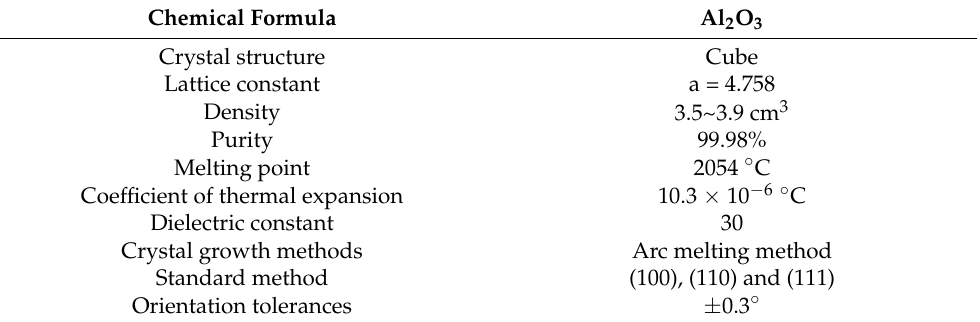
Table 2. The parameters of alumina.